Question: State the chart type depicted above.
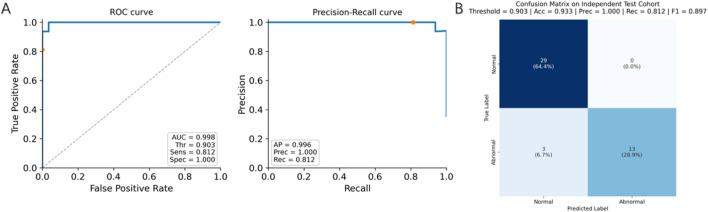
Answer: heatmap